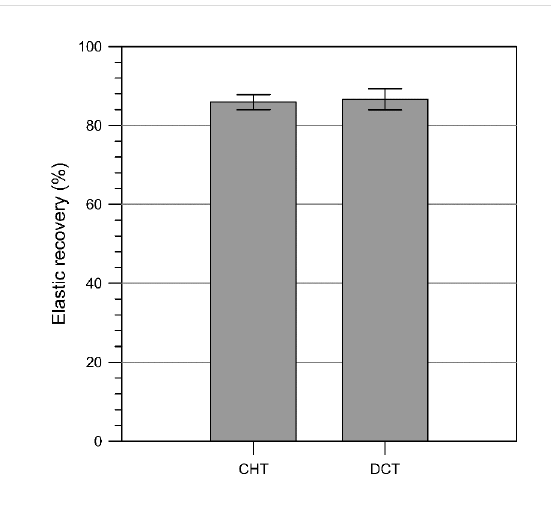
Figure 4: Elastic recovery values for nanoindentations performed with a conical indenter ( r ≈ 100 µm) at 1000 µN of normal load. Cryogenically treated specimens had a lower amount of total wear (Figure 5b), although this difference was only marginal.